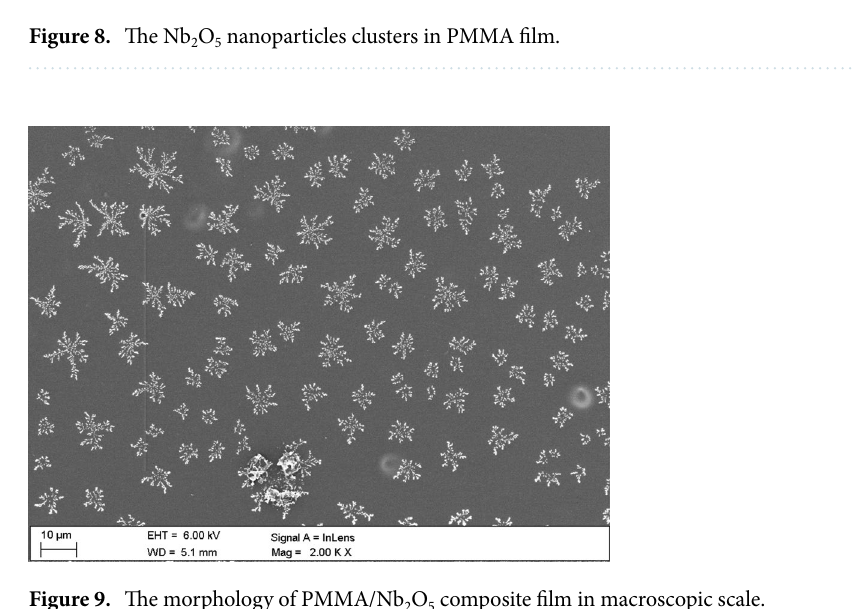
Figure 9. The morphology of PMMA/Nb 2 O 5 composite film in macroscopic scale.